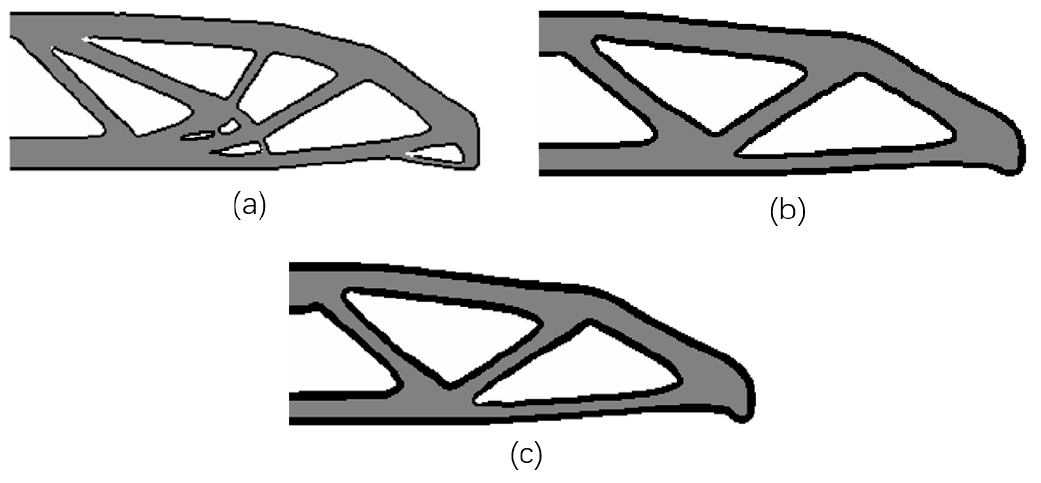
Figure 11. The optimized results with di ff erent boundary layer widths: ( a ) T = 2, R 2 = 5, c = 92.8804; ( b ) T = 4, R 2 = 10, c = 88.3850; ( c ) T = 6, R 2 = 15, c = 86.7072.